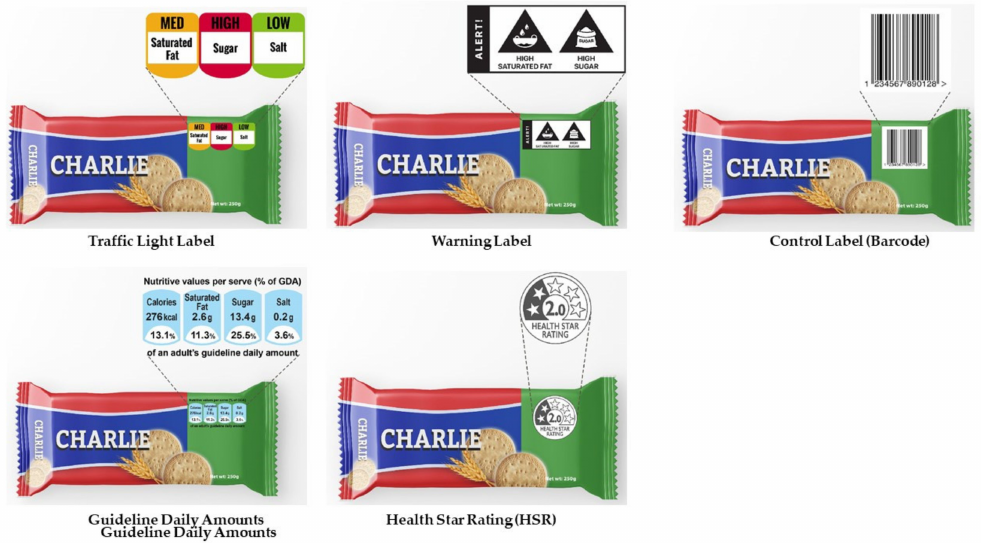
Figure 1. Front-of-package labels